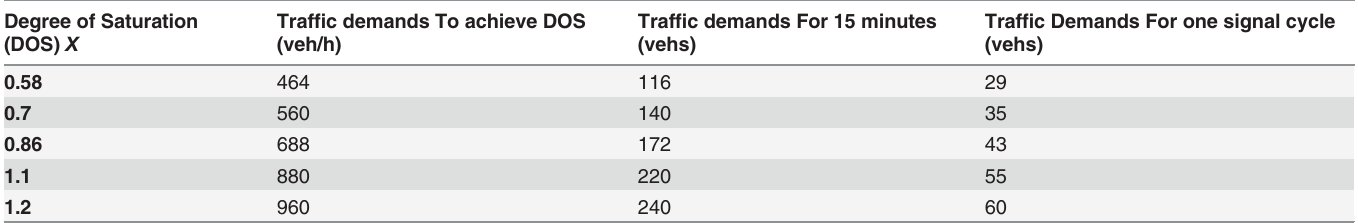
Table 2. Traf fi c demands for the link model ( capacity = 800